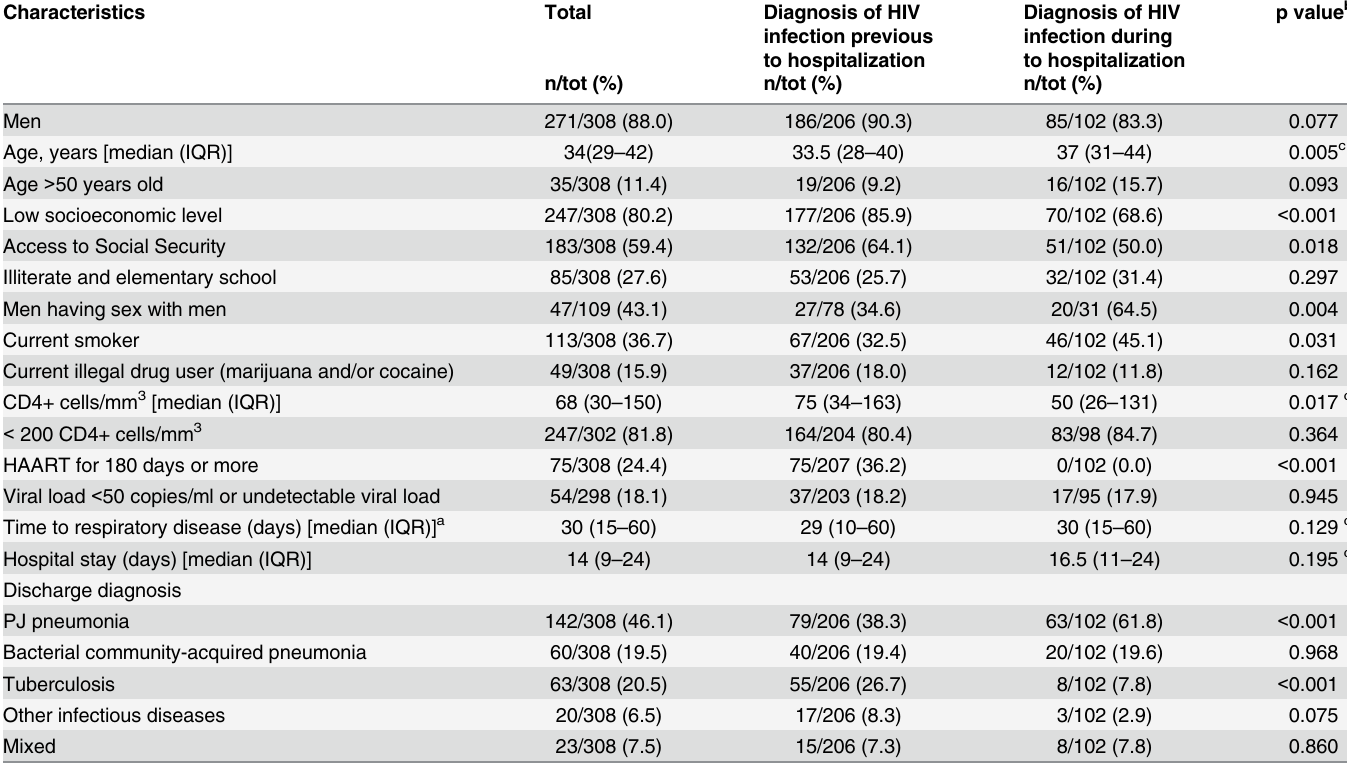
Table 2. Characteristics of HIV/AIDS patients in a specialty hospital for respiratory diseases in Mexico City, from January 2010 to December 2010, according to diagnosis of HIV infection previous to